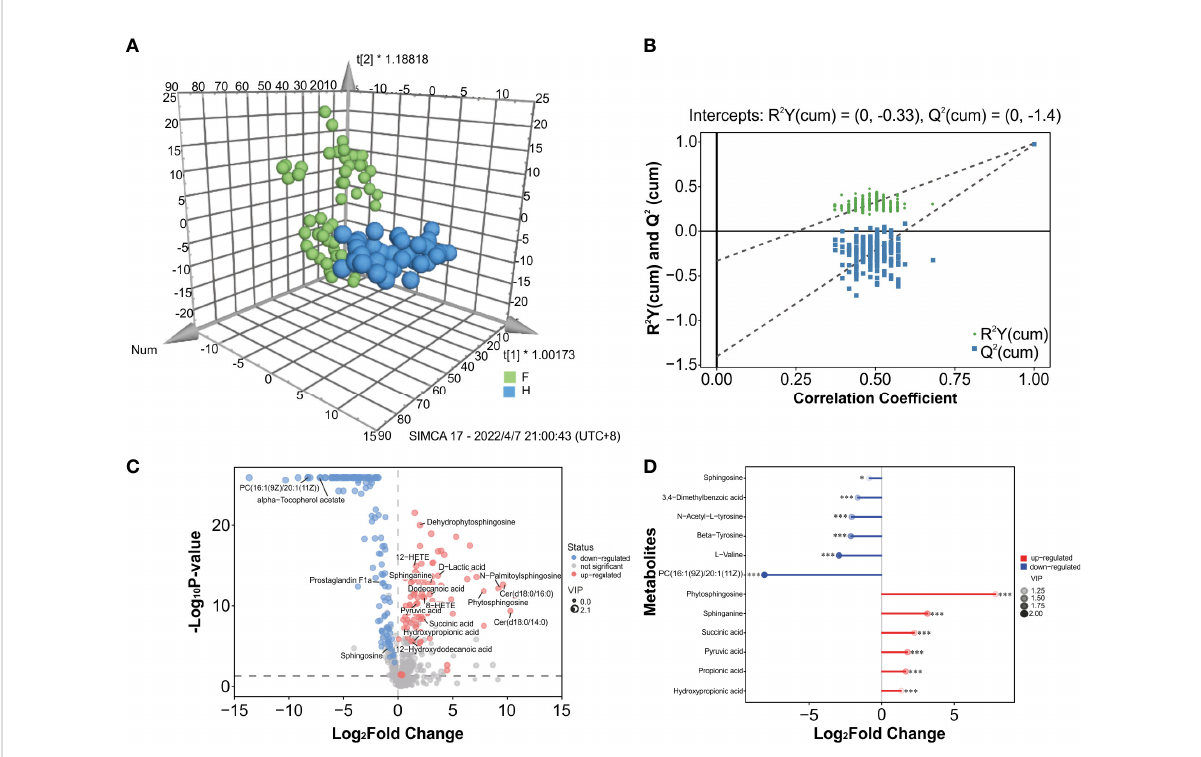
FIGURE 4 Metabolite differences between the IAV pneumonia group F and the healthy group H. (A) The OPLS-DA 3D plot of the oropharyngeal samples from both groups ( p < 0.001) are shown. F, IAV pneumonia group (green circle); H, healthy group (blue circle). (B) The OPLS-DA permutation test indicates good model robustness, with no over fi tting (n = 200). (C) Volcano plots showing differences in oropharyngeal metabolites between children with IAV pneumonia and healthy controls: upregulated metabolites (red circles), downregulated metabolites (blue circles). (D) Important discriminatory metabolites are displayed on the matchstick diagram. *p < 0.05; ***p < 0.001. The abscissa shows the log-transformed change multiple, and the dot color depth represents the VIP value size. IAV, in fl uenza A